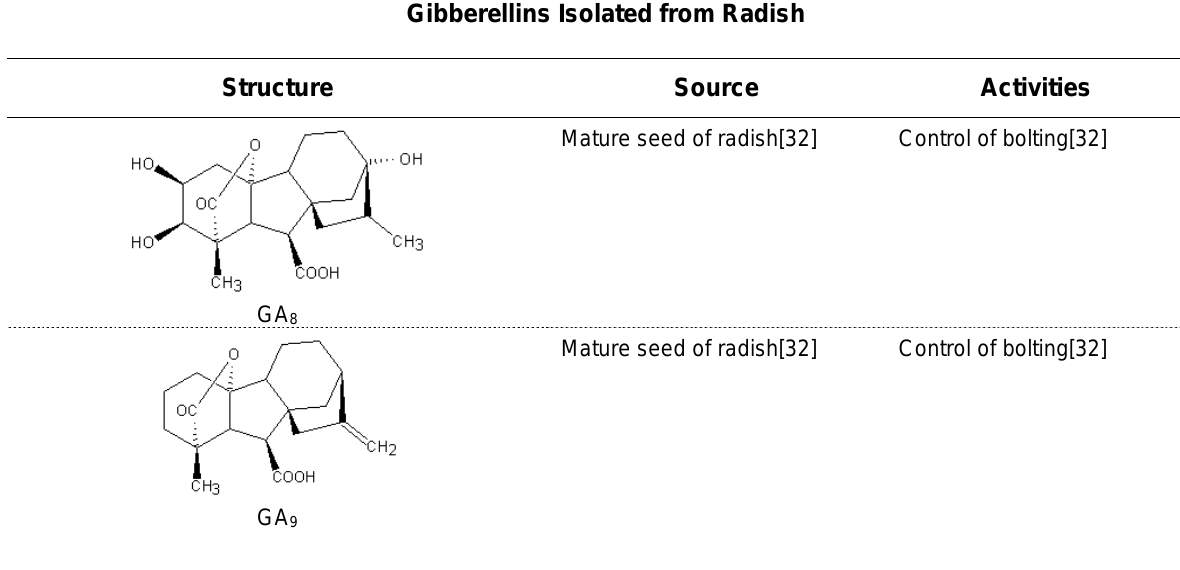
Gibberellins Isolated from